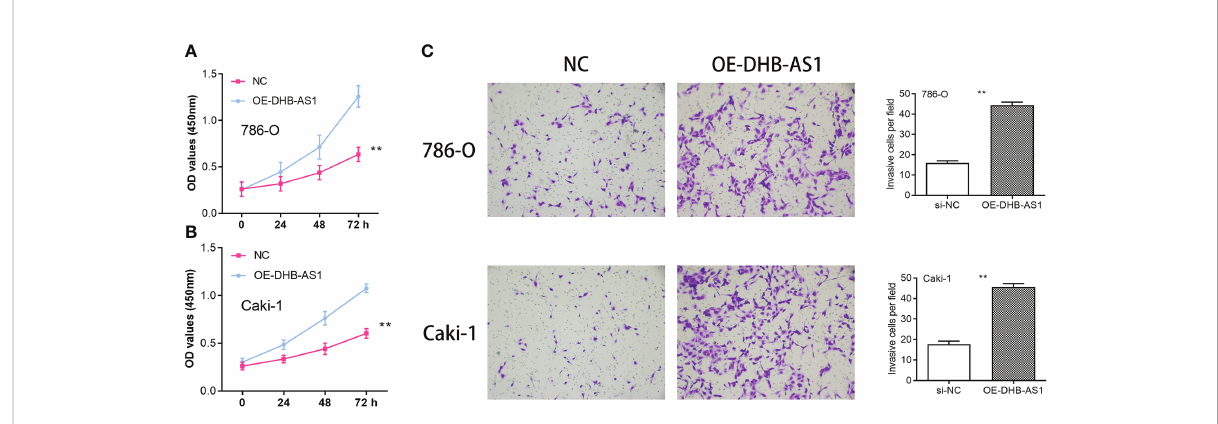
FIGURE 9 (A, B) Cell Counting Kit-8 Assay in 786-O and Caki-1 cells. (C) Transwell assay in 786-O and Caki-1 cells ** P <